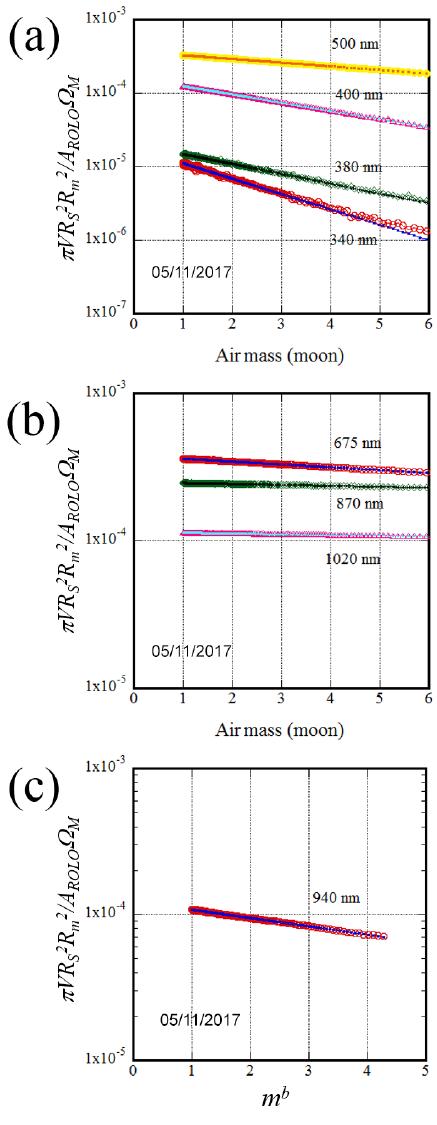
Figure 3. Examples of the Langley plot in the visible and near- infrared region on 5 November 2017. The y axis is the equation in parentheses on the left-hand side of Eq. (11). (a) 340, 380, 400, 500nm; (b) 675, 870, 1020nm; (c) 940nm, modified Lang- ley method.